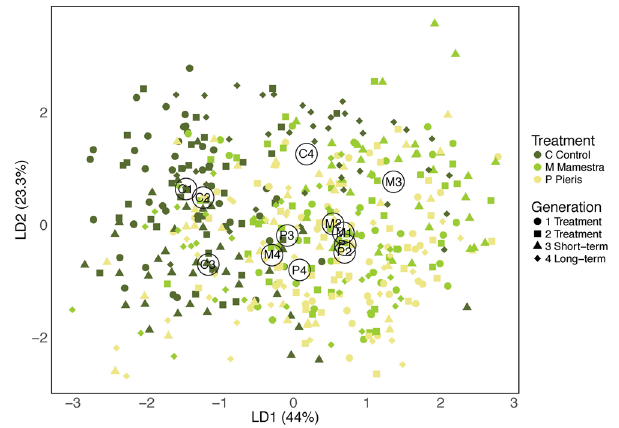
Figure 2. Result of the linear discriminant analysis (Wilks’ Λ (453,11): 0.242, F = 3.387, P < 2.2 × 10 − 16 ). The first two dimensions (LD1 and LD2) explain 44.0% and 23.3% of the observed group variance (see Supplementary Table S2 for loadings of LD1 and LD2). The analysis was conducted with ranked and z-transformed data of all measured traits except total petal area and leaf VOCs. Letters indicate centroid positions of Mamestra brassica (M) and Pieris brassicae (P) treated plant groups as well as the control groups (C) of generation 1–4.